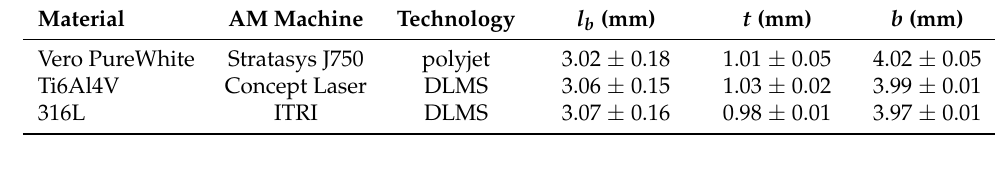
Table 2. Dimensions of specimens from additive manufacturing.